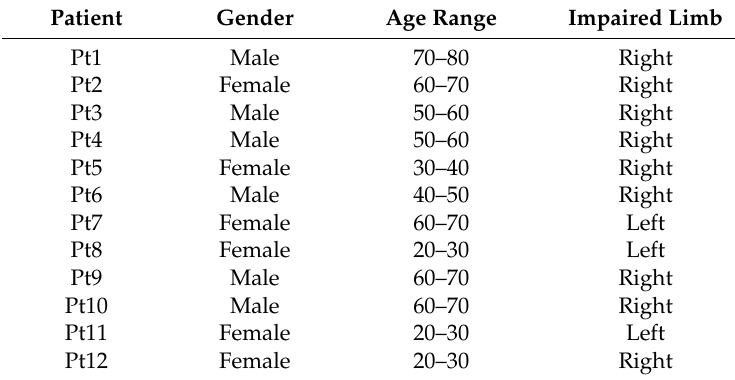
Table 2. Demographic data of